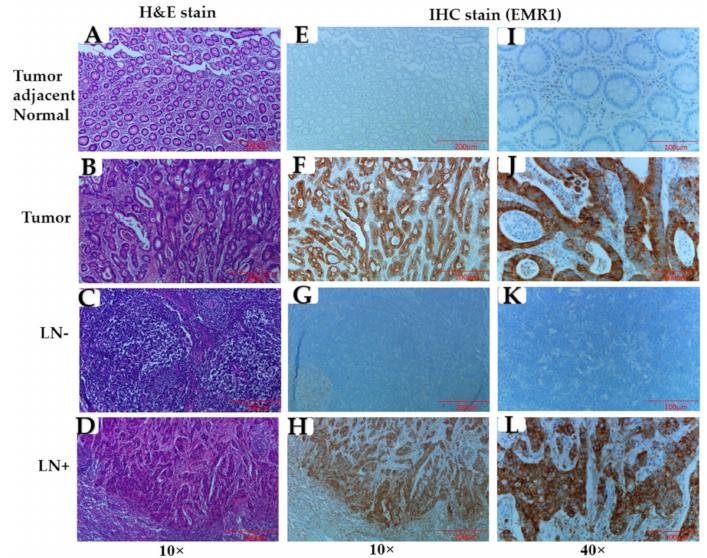
Figure 1. EMR1 expression in primary tumor and lymph node (LN) of colorectal cancer. ( A–D ) Colon tissues stained with hematoxylin and eosin (H&E); and ( E – L ) EMR1 immunohistochemistry (IHC) staining. ( A , E , I ) tumor adjacent normal area; ( B , F , J ) tumor area; ( C , G , K ) non-metastasis lymph node, LN − ; and ( D , H , L ) metastasis lymph node, LN + . Total number of samples, n = 399. Total number of samples used for representative images, n = 3. Original magnification, 10 × and 40 ×